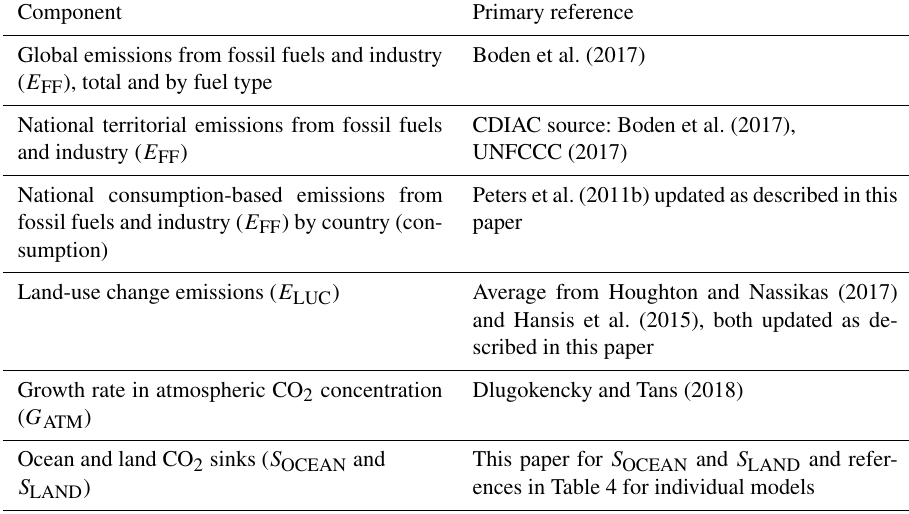
Table 2. How to cite the individual components of the global carbon budget presented